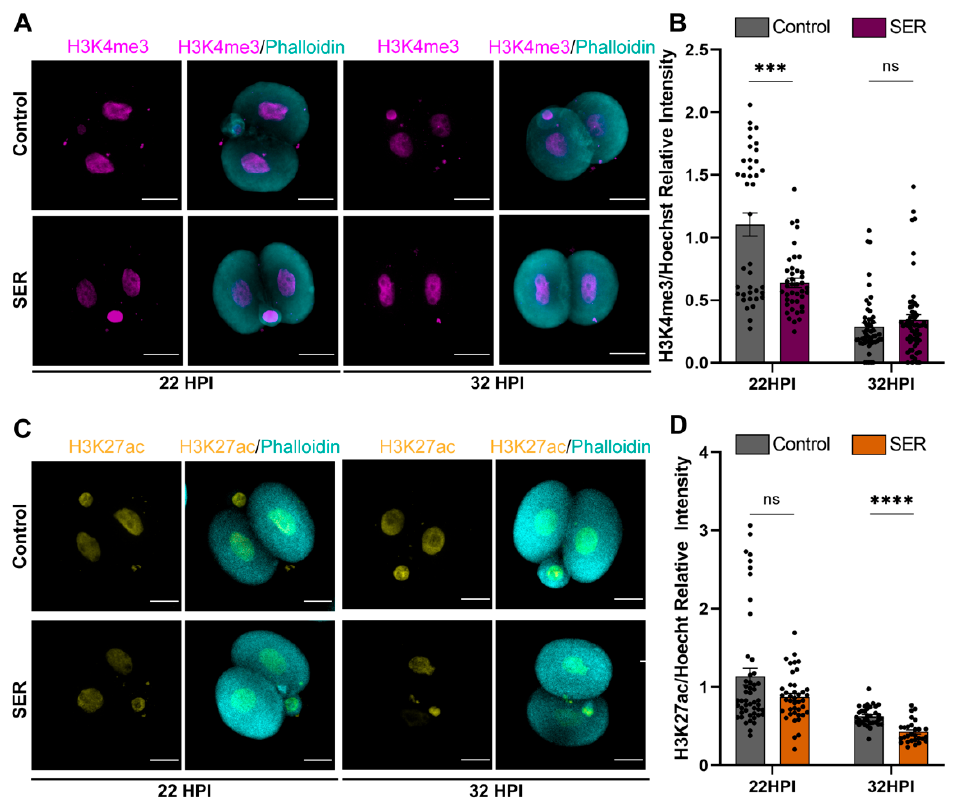
Figure 5. Post ‐ translational histone modifications H3K4me3 and H3K27ac during the timing of ZGA. ( A ) Representative confocal microscopy images of H3K4me3 (magenta) stained control ‐ and SER ‐ generated embryos at 22 and 32 HPI. Cortical actin cytoskeleton (Phalloidin) is shown in cyan. Male PN: ♂ ; female PN: ♀ ; and scale bar: 20 μ m. ( B ) Quantification of H3K4me3/Hoechst relative intensity of control ‐ and SER ‐ generated embryos at 22 and 32 HPI. N = 5 independent experiments, 15–20 embryos per time point per condition. Data are mean ± s.e.m. ns p > 0.05, *** p < 0.001 (unpaired T ‐ test). ( C ) Representative confocal microscopy images H3K27ac (yellow) stained control ‐ and SER ‐ generated embryos at 22 and 32 HPI. Cortical actin cytoskeleton (Phalloidin) is shown in cyan. Male PN: ♂ ; female PN: ♀ ; and scale bar: 20 μ m. ( D ) Quantification of H3K27ac/Hoechst relative intensity of control ‐ and SER ‐ generated embryos at 22 and 32 HPI. N = 4 independent experiments, 15–20 embryos per time point per condition. Data are mean ± s.e.m. ns p > 0.05, **** p < 0.0001 (unpaired T ‐